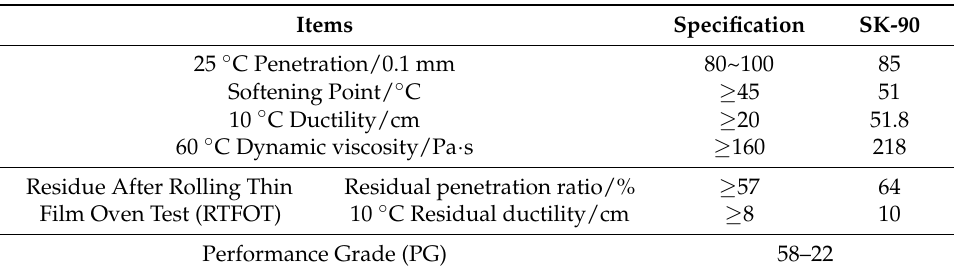
Table 1. Physical Properties of